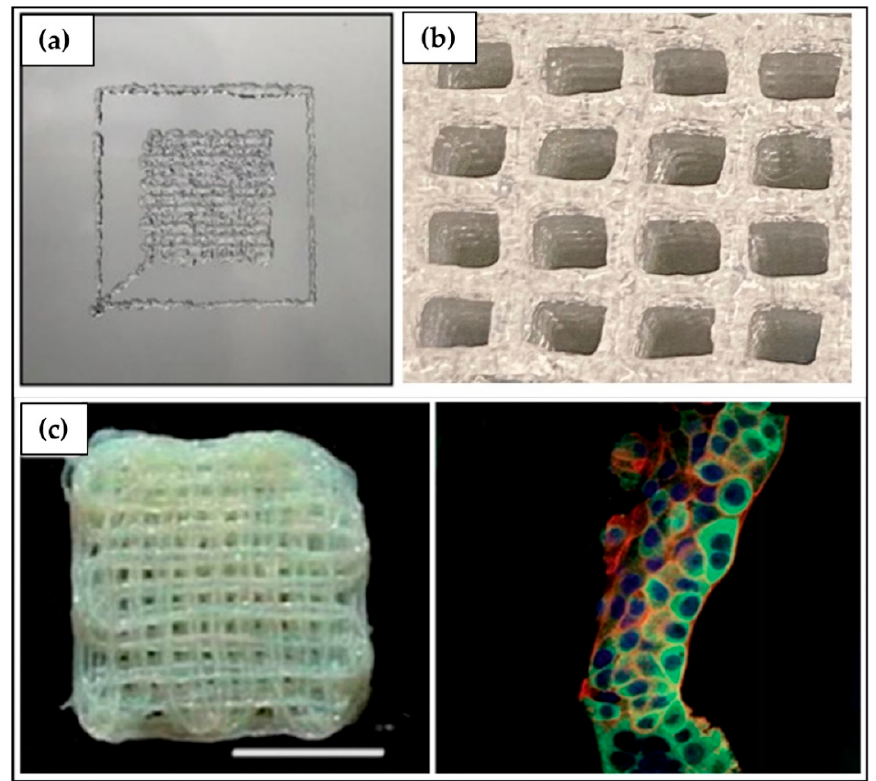
Figure 7. Hydrogel-based scaffolds by additive manufacturing (AM). ( a ) Top view of 3D bio-printed construct based on GelMA [192], ( b ) photographic image of ten-layer printed scaffold with Ink H4- RGD [193] and, ( c ) representative photograph of a chitosan/ γ -PGA PEC hydrogel and representative confocal laser scanning microscopy micrograph of BxPC-3 cells grown on the PEC hydrogel